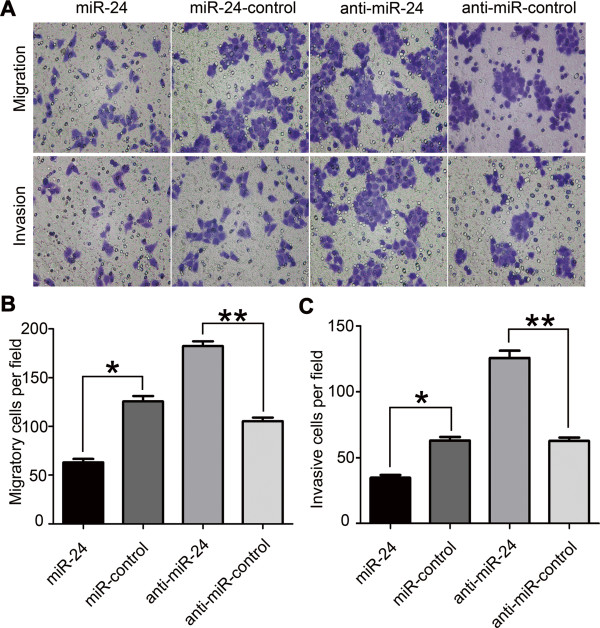
miR-24 inhibited migration and invasion of SGC-7901 cells. (A) Representative fields of SGC-7901 cells in the transwell assays. (B, C) Representative fields of SGC-7901 cells in the migration and invasion assays, respectively. Average number of migration and invasion cells per field from three independent experiments (*P < 0.05, **P < 0.01).